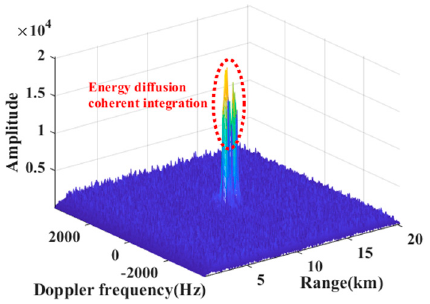
Figure 11. Coherent integration results (Tr = 130us).